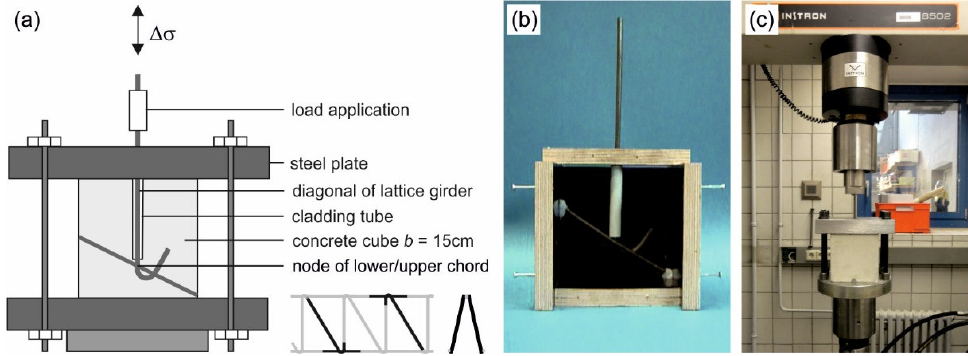
Figure 6. Schematic depiction of fatigue test setup ( a ), node of lattice girder in formwork ( b ), and test setup for fatigue tests ( c )